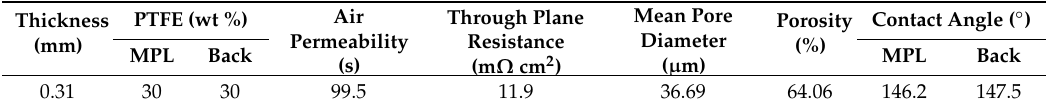
Table 2. Physical properties of